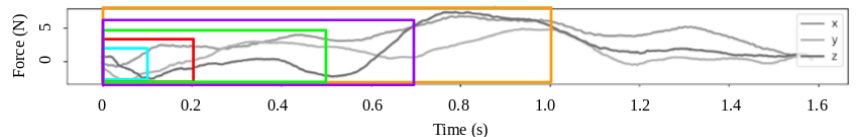
Figure 5. Sampling windows evaluated to find an optimal classification-reaction time ratio. The windows correspond to: 0.1 s (cyan), 0.2 s (red), 0.5 s (green), 0.7 s (purple), and 1 s (orange). Recall that one second is our task limit time for achieving a suitable human–robot